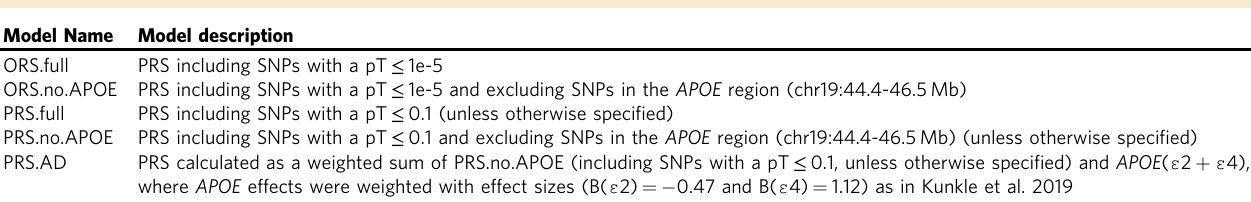
Table 1 Model description for the PRS models presented in the manuscript. Model Name Model